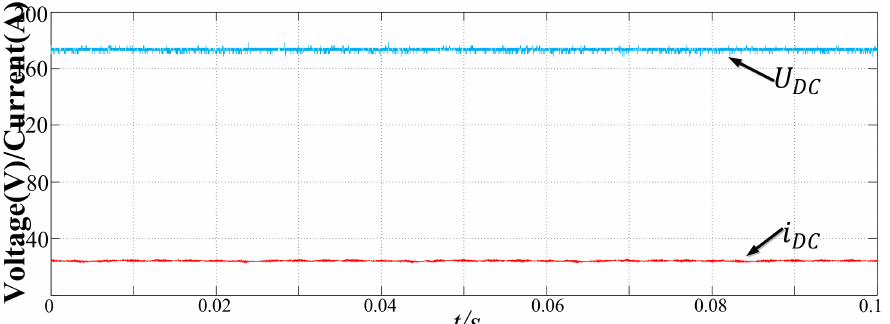
Figure 16. The waveforms of the DC-link voltage and